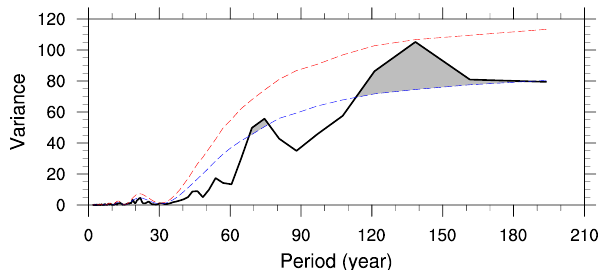
Figure 10. Same as Fig. 9 but for 31-year RCs in the CESM-LME control experiments. The dashed line represents 90% significance test